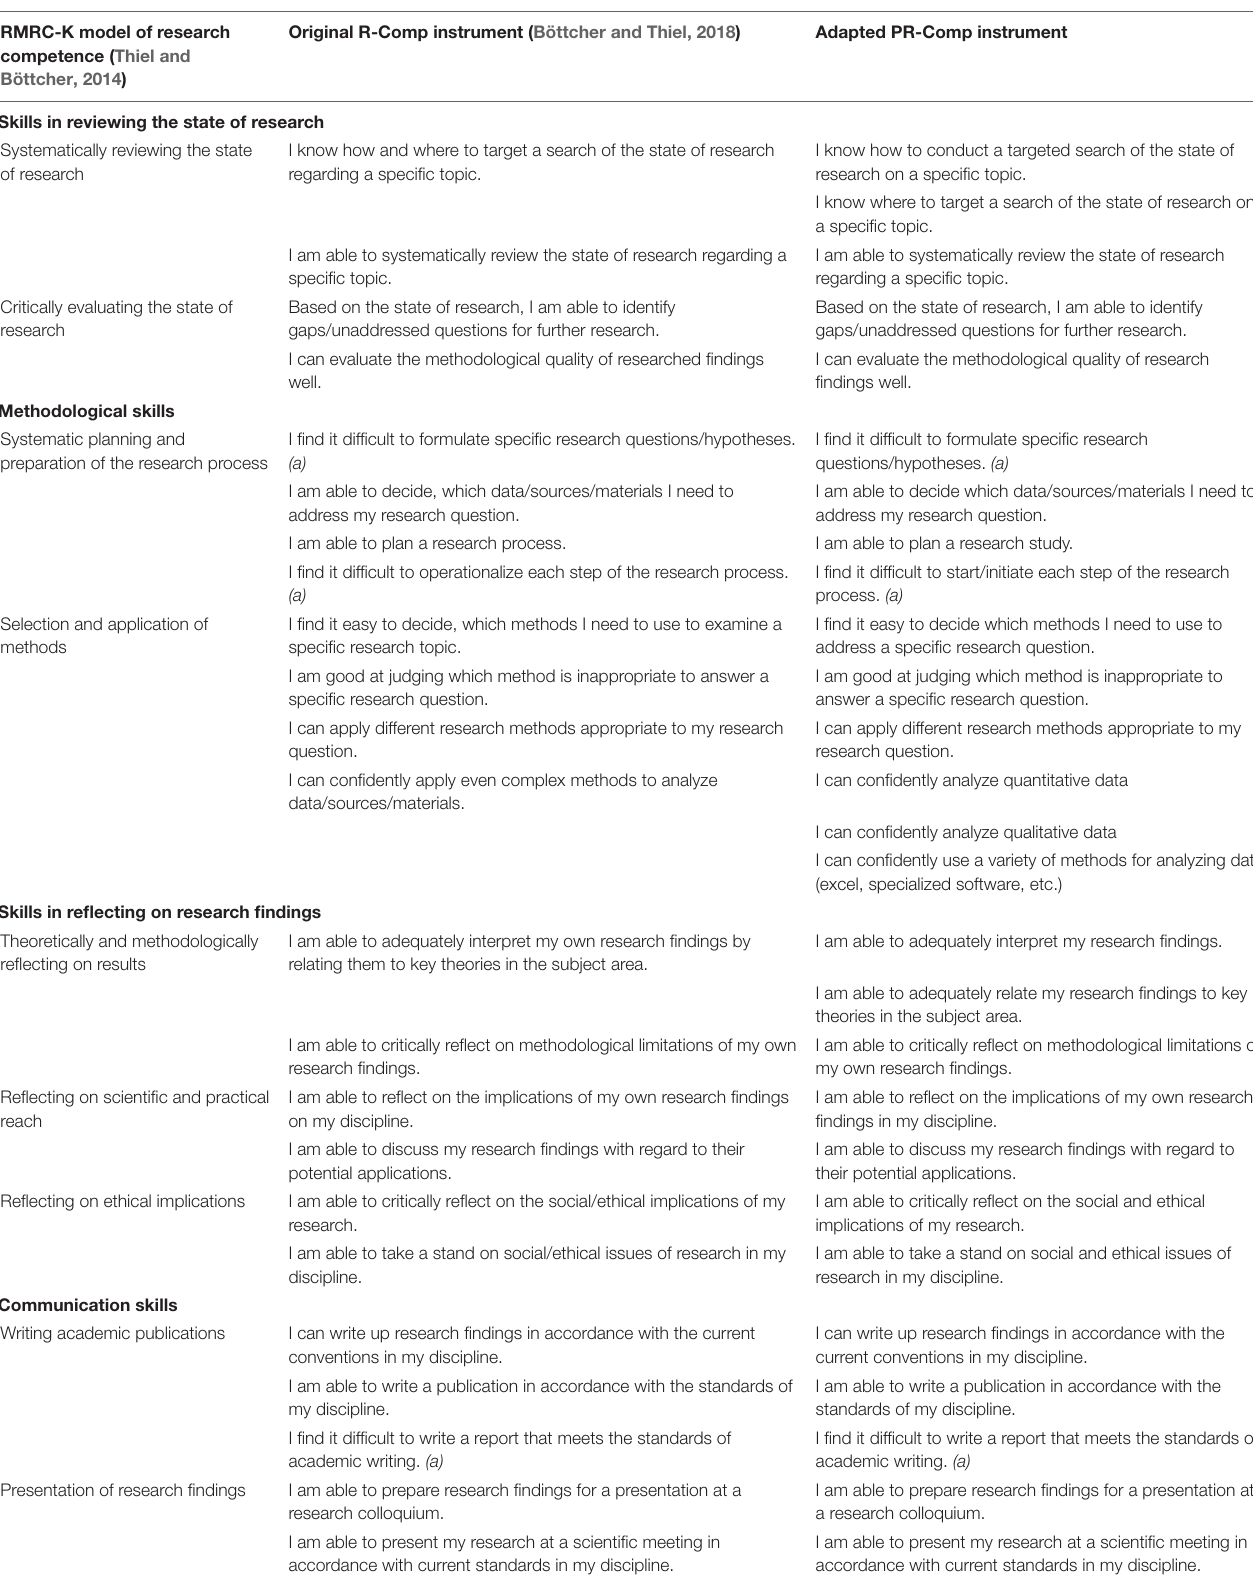
TABLE 2 | The adapted PR-Comp items compared to original R-Comp items by